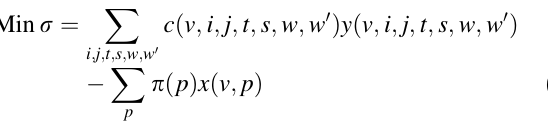
Fig. 3 Data flow chart of